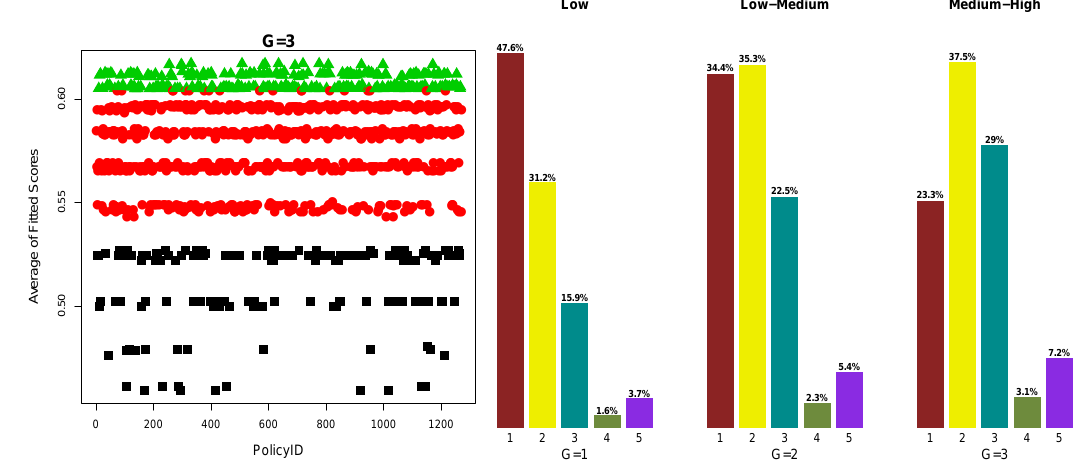
Figure 1. Scatter plot depicting the clustering composition for R = 3 ( left ) claim clusters. Different color and shape symbols represent the clusters: Cluster 1 (square), Cluster 2 (circle), and Cluster 3 (triangle). The bar plot ( right ) displays the profile of the claims in each cluster. The percentage represents the probability θ gjk in each category (Equation